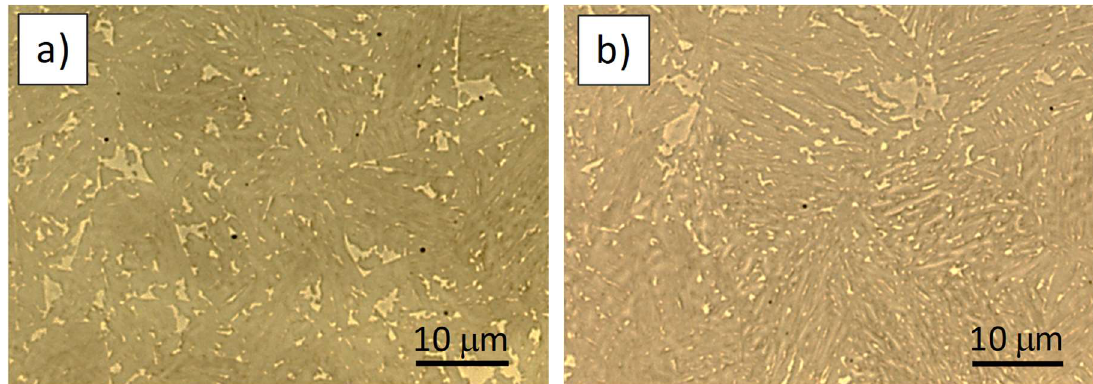
Figure 1. Optical Micrographs (Klemm etch) of Ref and Ref + V alloys isothermally transformed at 375 ◦ C in the synchrotron ( a ) Ref and ( b ) Ref + V. The light colored phase is martensite / retained austenite.